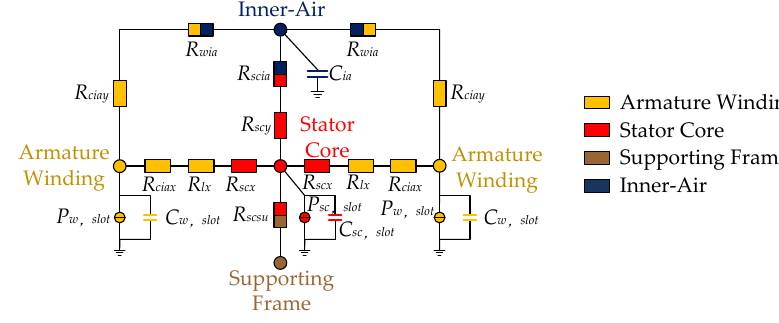
Figure 5. Thermal model of the single-segmented stator.